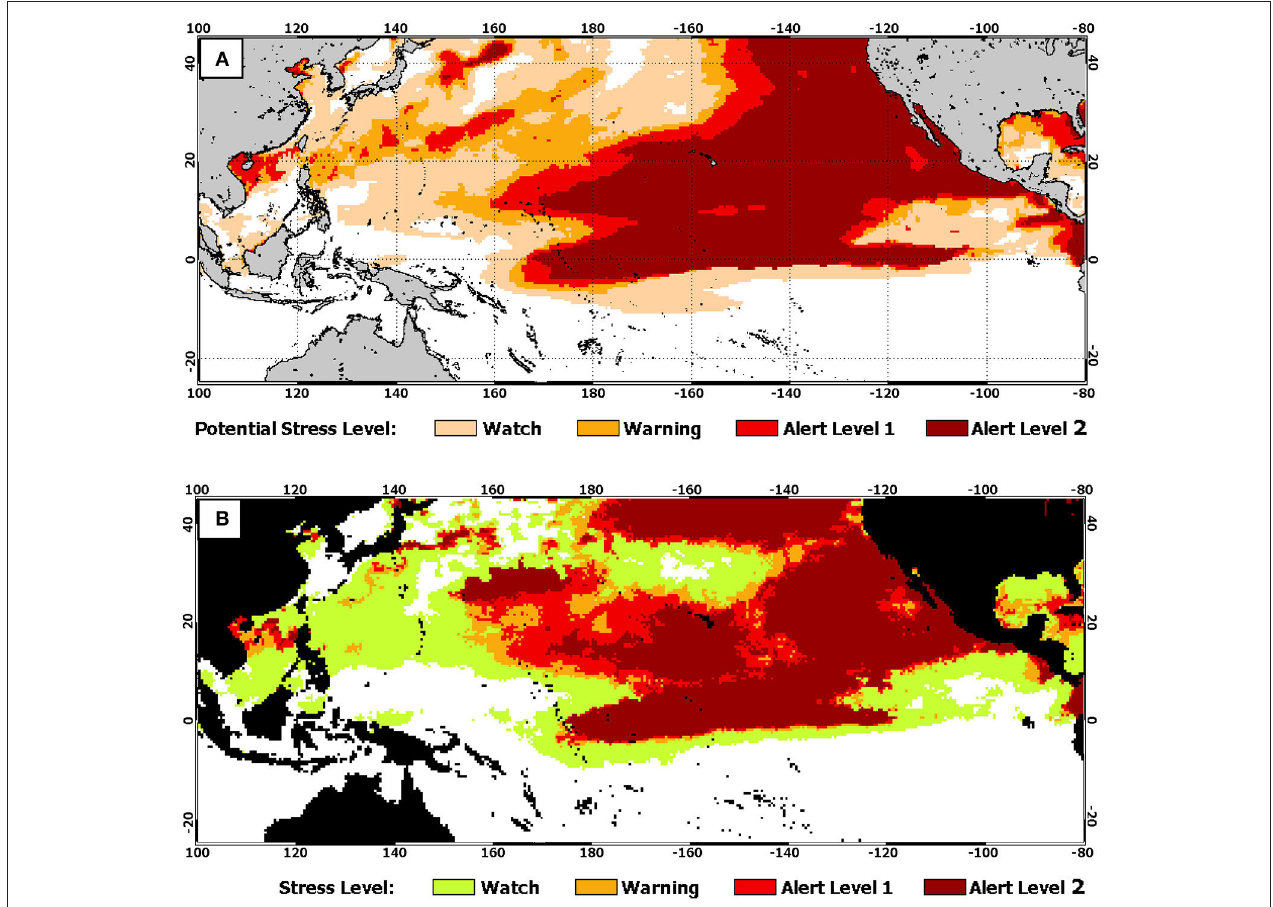
FIGURE 13 | CRW’s (A) 4-Month Outlook (Version 3) of 60% probability issued on July 7, 2015 for July–October 2015, predicting Alert Level 2 at the southeast end of the NWHI and in the Main Hawaiian Islands (MHI) during summer/fall 2015, and the (B) monthly maximum 50km satellite Bleaching Alert Area for September 2015, observing Alert Level 2 in the same